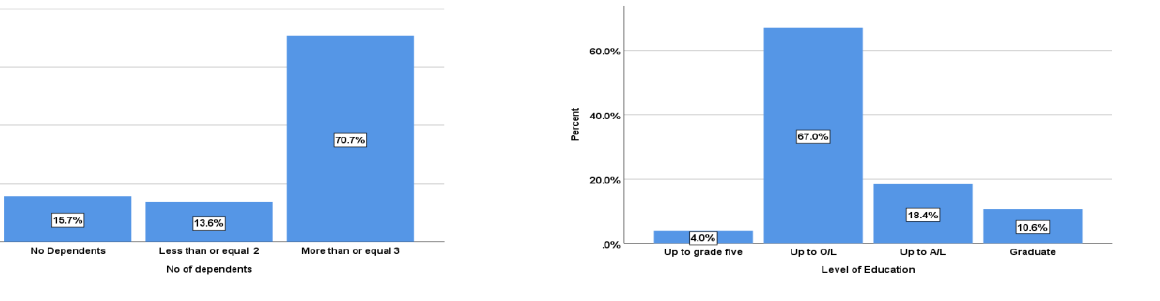
Figure 2: Number of dependents for each household Figure 3: Education